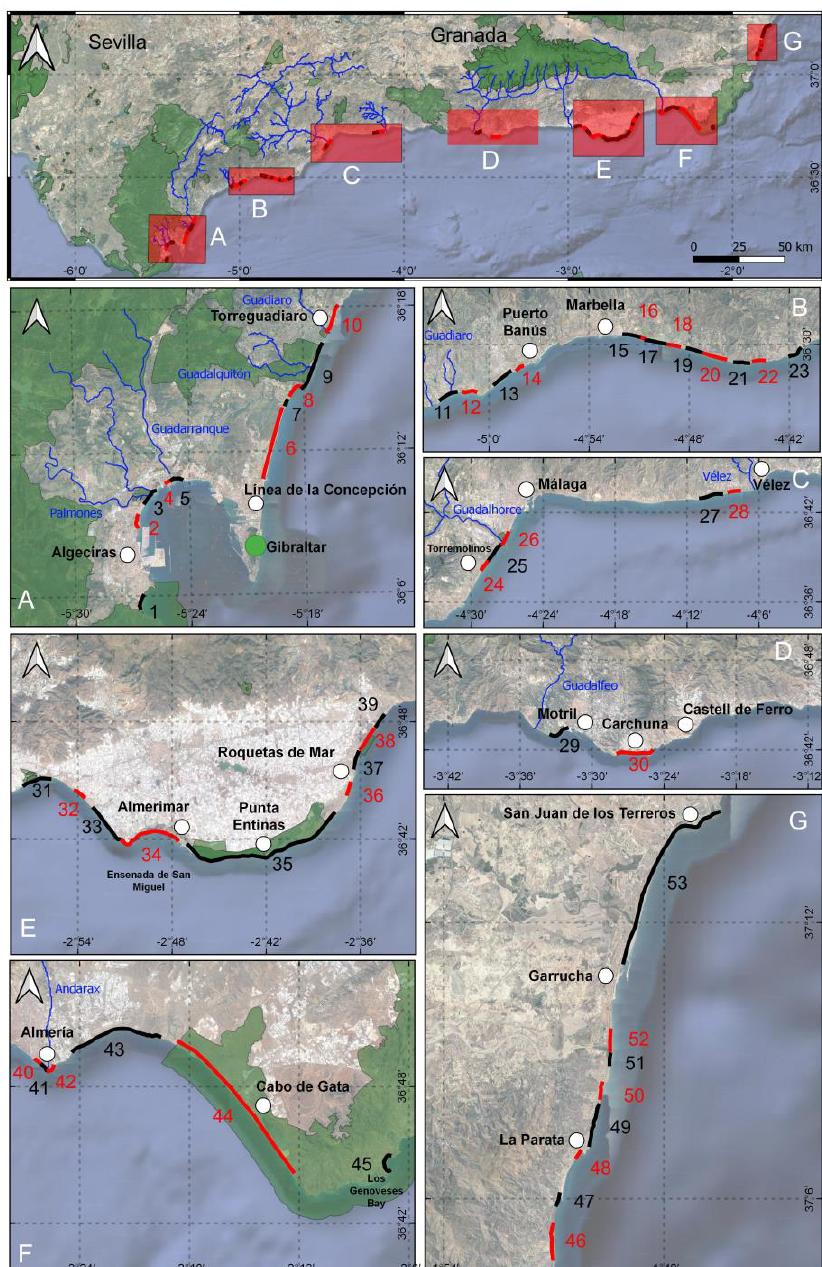
Figure 2. Location of the studied dune systems. Natural protected areas are in green. The capital letters A – G in the main subplot refer to the zoomed areas in the other subplots.